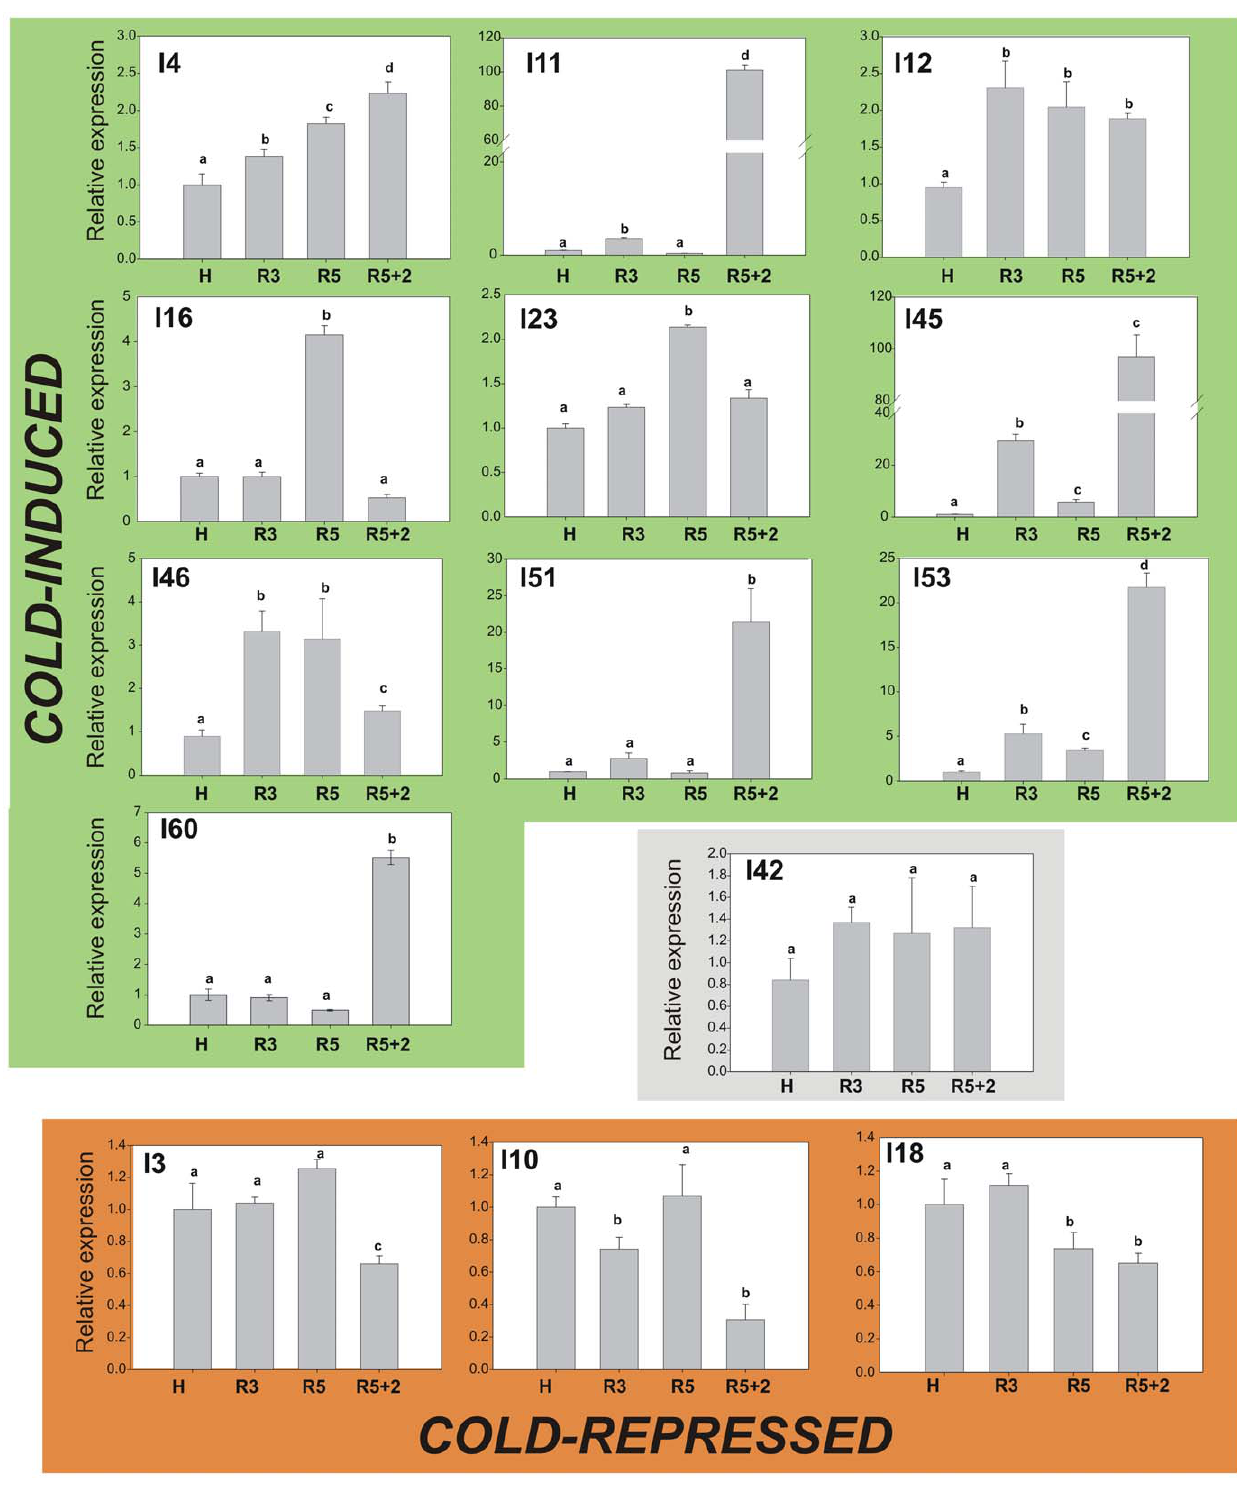
Figure 4. Heat-induced unigenes in cold-treated peach fruit. The relative-to-harvest (H) level of accumulation of 14 selected heat-induced transcripts was determined in peach fruit subjected to 3 (R3) or 5 days at 0 u C (R5) followed by 2 days at 20 u C (R5 + 2). Gene expression levels were normalized against Arabidopsis thaliana rad50 (gb|AF168748.1|AF168748). Bars with at least one equal letter mean no statistically significant difference ( a =0.05). Cold-induced genes are grouped in green, cold-repressed transcripts in red and the transcript that was not modified by the cold treatment (I42) is in grey.